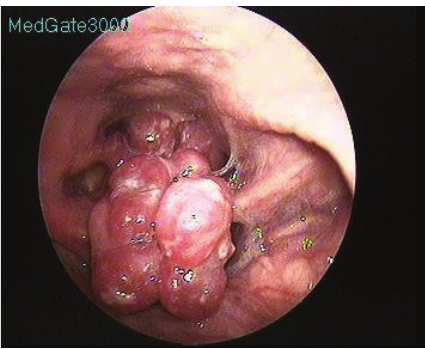
Figure 1: Pink and purple colored mass with lobular contours on the epiglottis laryngeal surface near the aryepiglottic fold.